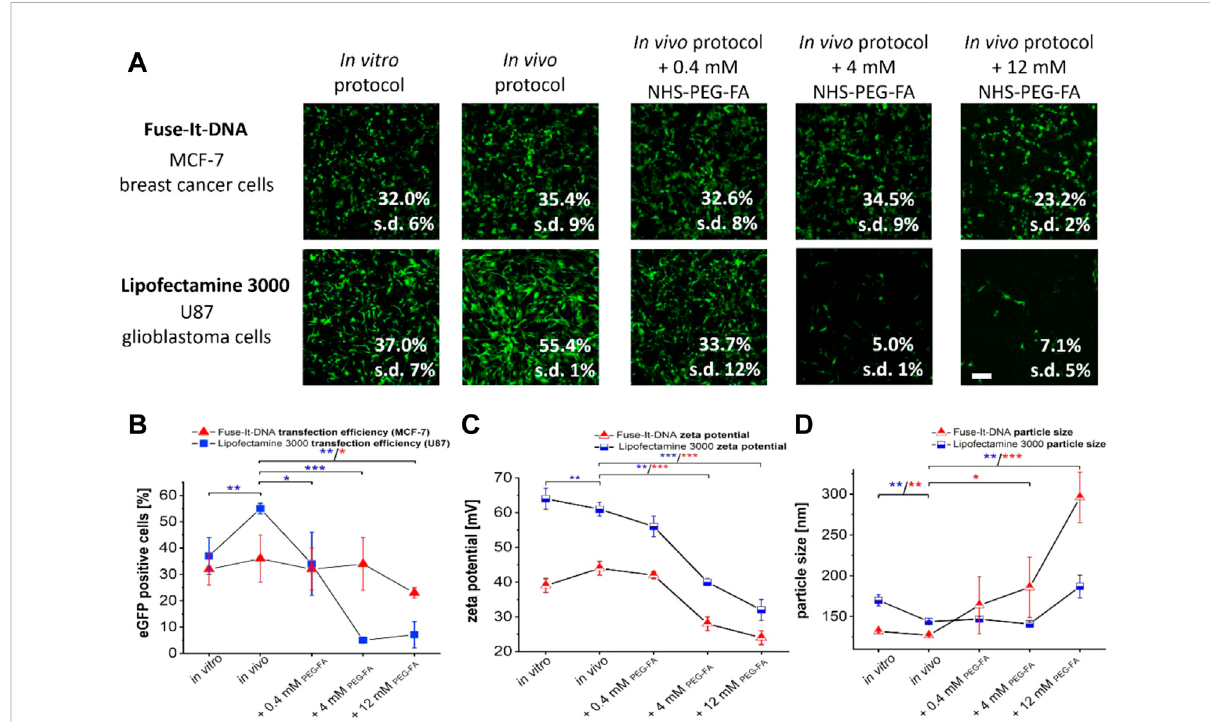
FIGURE 2 Developmentof invivo applicabletransfectionprotocolsandfunctionalizationofFuse-It-DNAaswellasLipofectamine ® 3000withPEG-FA.To optimizemanufacturer ’ stransfectionprotocols( invitro protocols)for invivo applications,protocolswereestablishedthatrequireminimumvolumes to transfer 1 μ g of plasmid ( in vivo protocol). In addition, lipoplexes were functionalized with different molarities of NHS-PEG-FA-stocks with concentrations between 0.4 to 12 mM by post modi fi cation. Analysis of transfections was performed by fl uorescence microscopy and fl ow cytometry (A) . The in fl uence of PEG-FA modi fi cation on transfer ef fi ciencies is shown in (B) . Unmodi fi ed complexes as well as the PEG-FA modi fi ed complexes were characterized for zeta potential (C) and complex size (D) . Scale bar 200 μ m. n = at least three independent